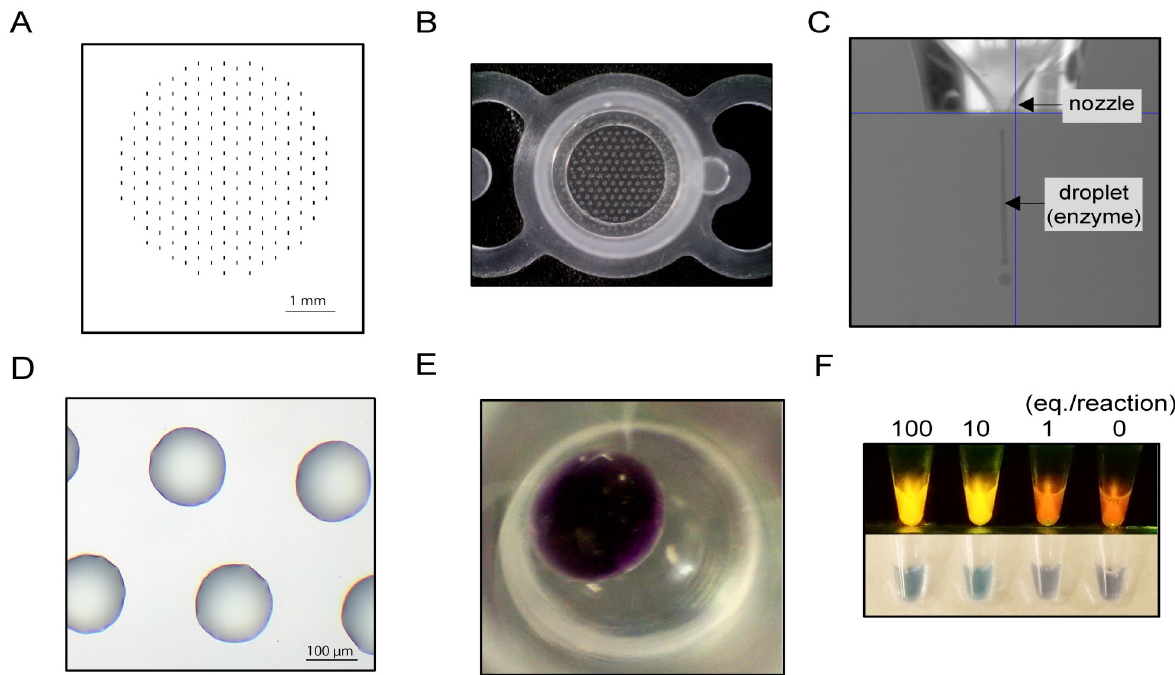
Fig 1. Dried format CZC-LAMP was produced by using a bio-inkjet printer. A) The bitmap file template used for bio-inkjet printing on the tube lid. B) LAMP test tube lid after printing of the enzyme. C) Image of the inkjet printer head while ejecting reagents. D) Microscopic image of LAMP test tube lid showing the regular shape of the sugar-glass array. E) Appearance of the tube bottom. The primers, dNTPs, and detection dye CFI were vitrified with trehalose. F) Representative image of the positive and negative results of CZC-LAMP HAT observed under LED light (upper) and by the naked eye (bottom). CZC-LAMP HAT reactions were incubated for 60 min at 63 ˚C with DNA at the indicated equivalent parasite concentration (eq./reaction).